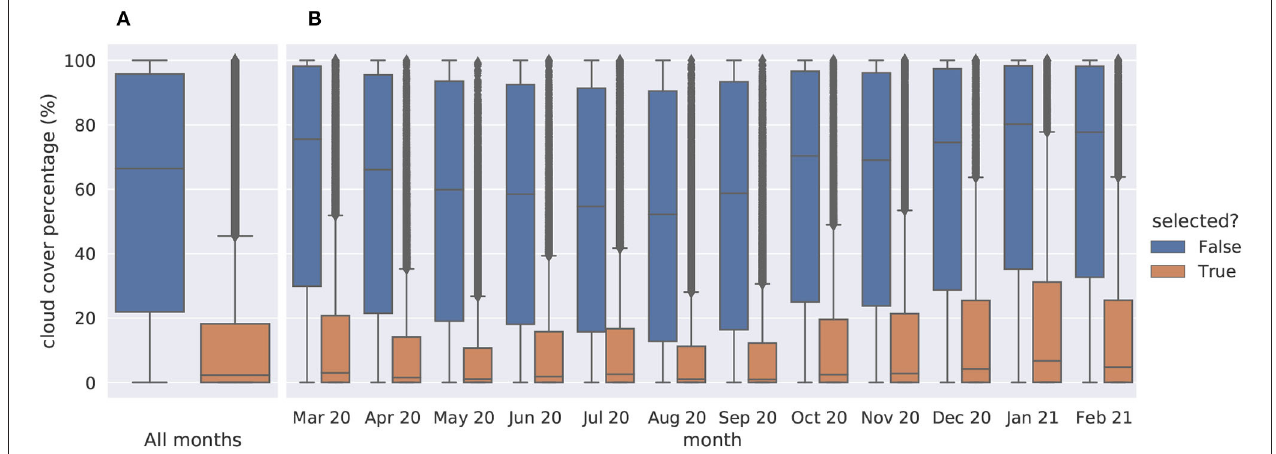
FIGURE 6 | Cloud cover percentages of the 1,067,989 tested products, 180,747 (16.9%) selected against 887,242 (83.1%) dismissed. (A) all months taken together, (B) detailed by